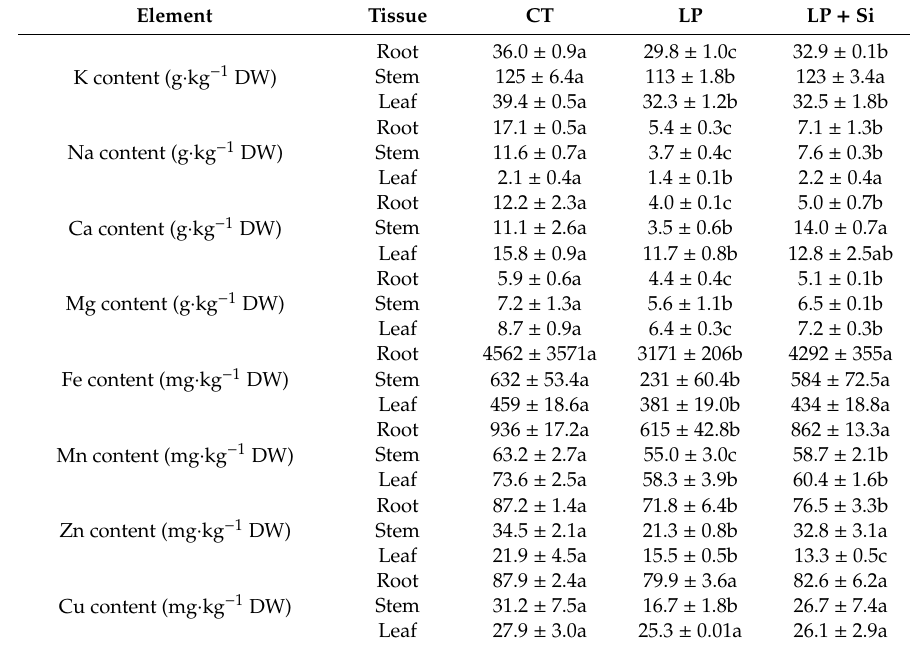
Data are shown as means ± SD, n = 3. Within each row (same tissue) followed by the same lowercase letters are not significantly different according to Tukey’s test at p ≤ 0.05. CT, control; LP, low phosphorus.